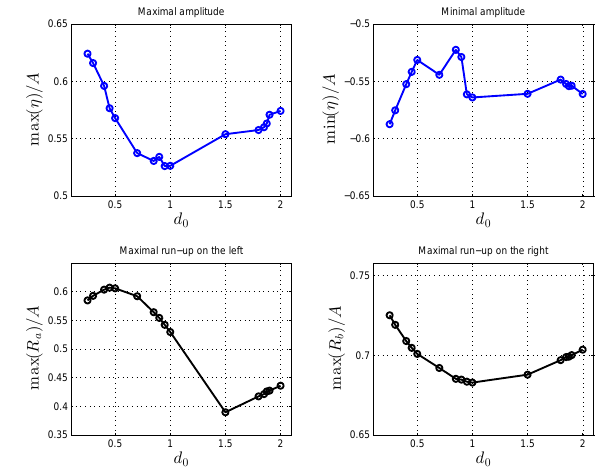
Fig. 16. Maximal and minimal wave amplitude, and the maximum run-up on the left and right beaches as a function of the initial depth of the center of the landslide d 0 .